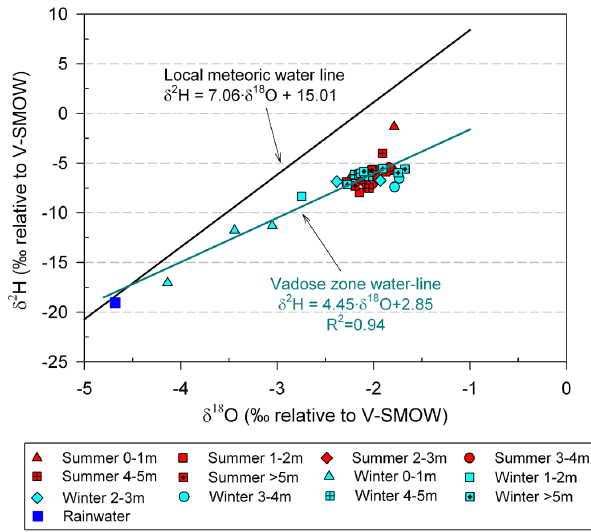
Fig. 5. δ 18 O vs. δ 2 H in rainwater and sediment samples from the vadose zone under the background site. Local meteoric water line is based on the data presented in the work of Asaf et al.